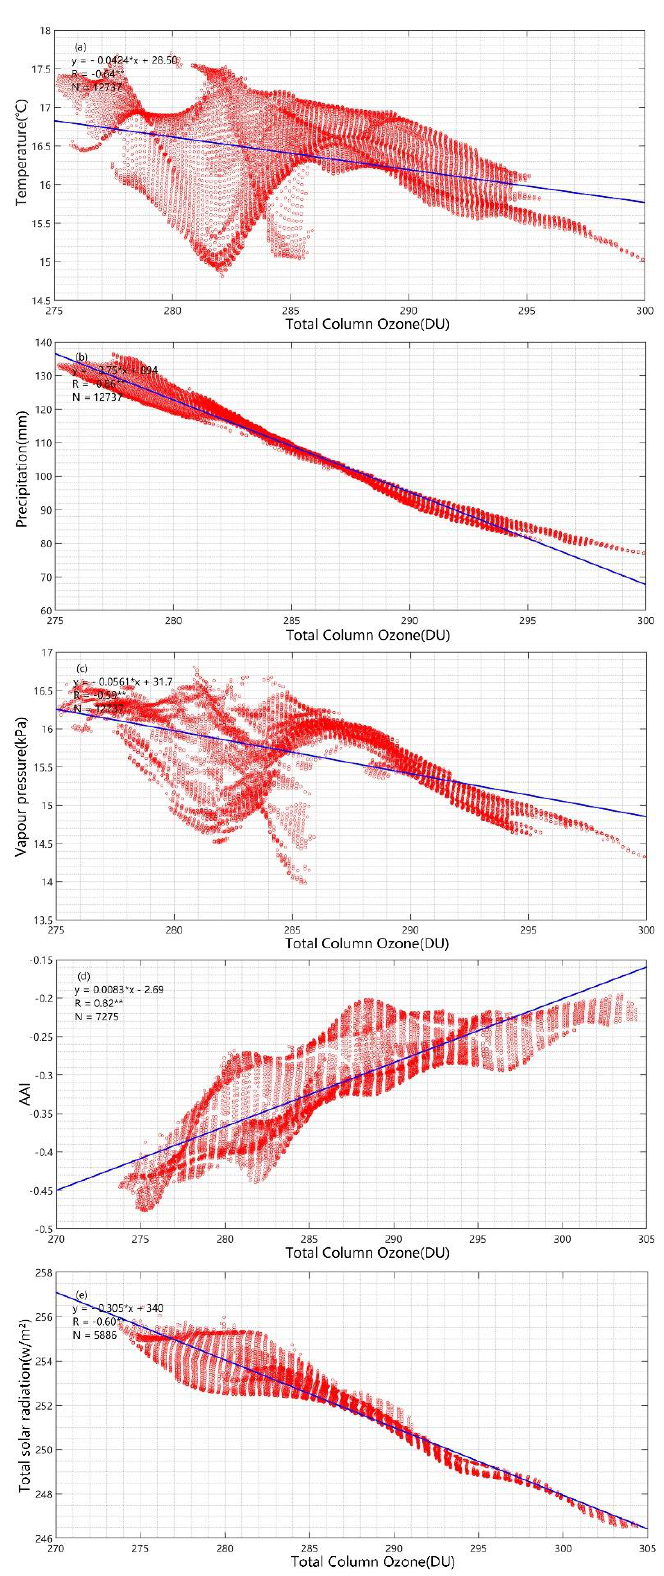
Figure A5. Scatter plot of inter-annual spatial variation of the TCO and meteorological factors.